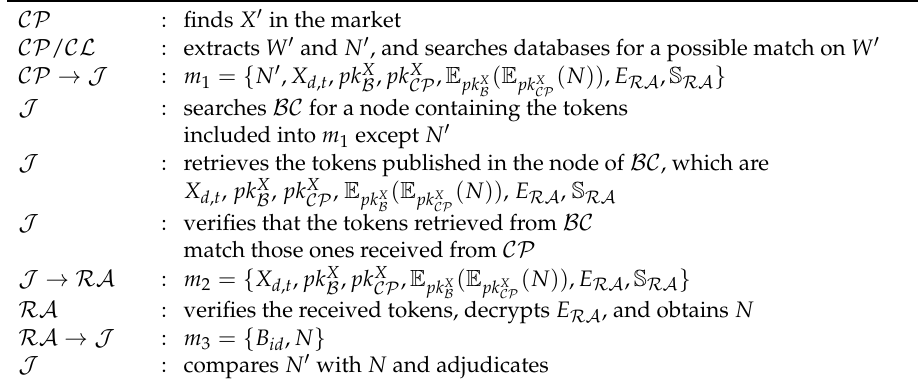
Table 4. Identification and arbitration